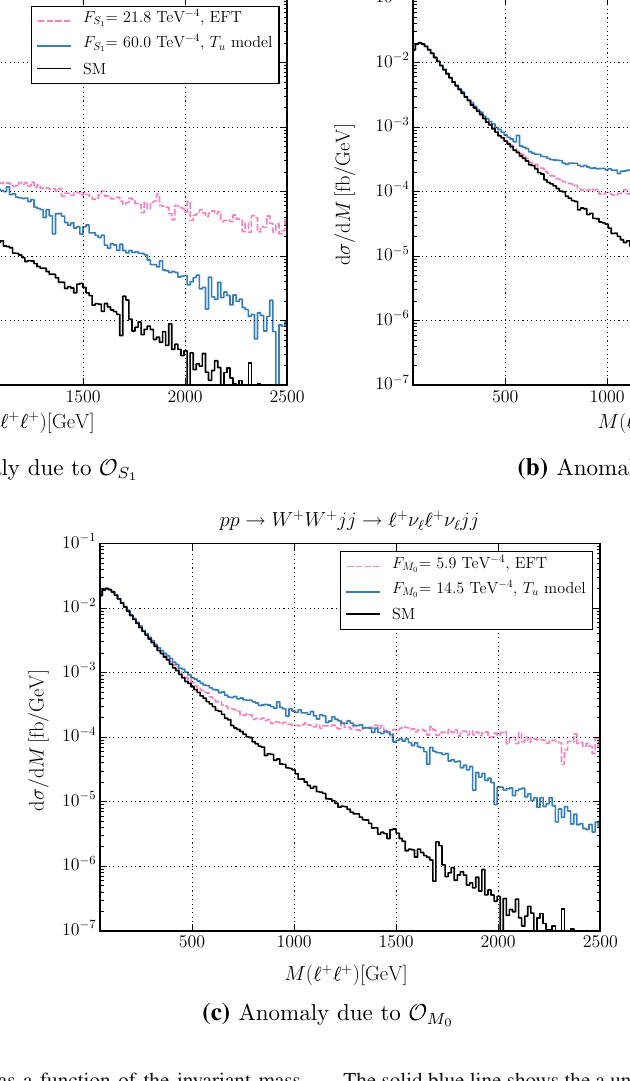
√ (cid:24) p (cid:24) p s = m WW are T ,(cid:6)(cid:6) are suppressed because T ,(cid:6)(cid:6) and highly correlated. The T u model prediction for the longitudi- nal operators and the SM have more events at (cid:24) p T ,(cid:6)(cid:6) below 1000 GeV and receive a large suppression for larger (cid:24) p T ,(cid:6)(cid:6) . As expected, the transverse operator produces a broader dis- tribution, i.e. the enhancement due to (λ 3 , λ 4 ) = ( + , + ) polarization is clearly visible. For this observable, the uni- tarization model even increases the discrimination power between different operators